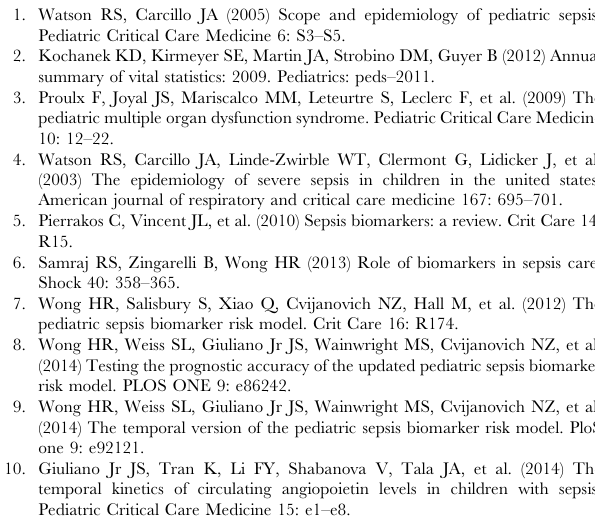
Figure S1 Sample size by study day. Samples were obtained twice per day for the first 3 days and then once per day for the last 4 days, for a maximum of 7 days and 10 samples. Sample collection was discontinued when the patient was discharged from the PICU, after the 7-day study completion, or when the clinical team deemed it unnecessary to draw further labs for patient care. File S1 Contains Table S1, Infectious organisms: Causative organisms isolated in patients. N gives the number of patients with a given proven infection. Table S2, Baseline patient characteris- tics: Statistical analysis of the baseline patient characteristics based on the evaluation distributions of the PICU/sepsis group and PICU severe sepsis group. Categorical variables, presented as count (percentage), were analyzed using Fisher exact test. Continuous variables, presented as mean (standard deviation), were analyzed using the two-tailed t test. P values are comparisons between two groups. Any significance level of P less than 0.05 is associated with the diagnosis. Text S1, Supplementary